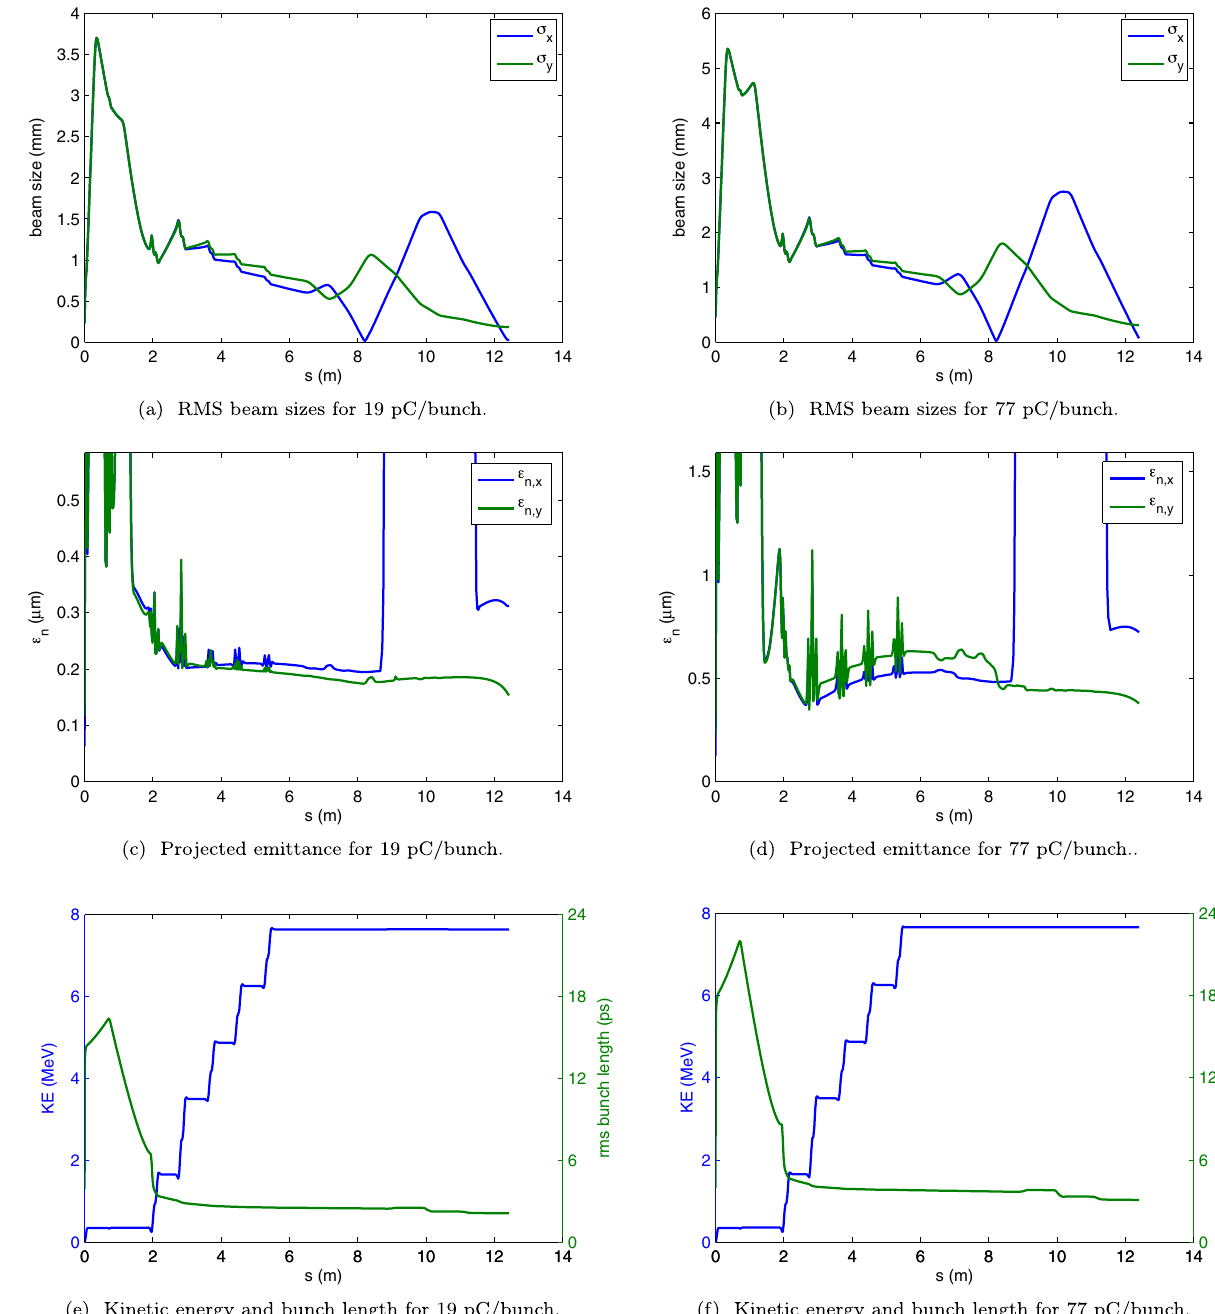
FIG. 13. Simulation data for the 19 pC = bunch (left) and 77 pC = bunch (right) injector settings: (a) and (b) show the rms beam size along the injector, (c) and (d) show the projected horizontal and vertical emittances, and (e) and (f) show both the kinetic energy (left axis) and rms bunch length (right